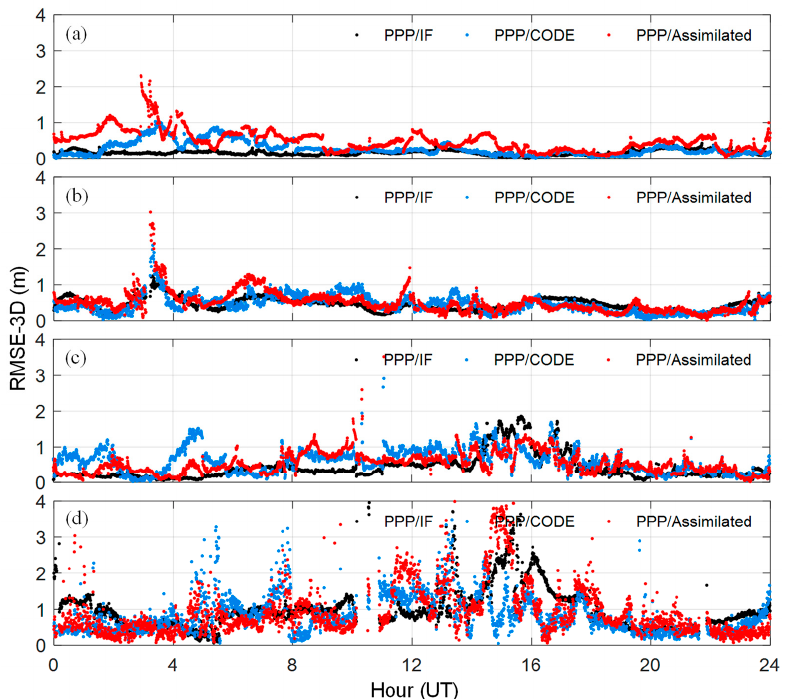
Figure 8. RMSE of 3D with each epoch at different stations on 8 September 2017. ( a ) GAMG; ( b ) JFNG; ( c ) LHAZ; ( d ) CMUM.